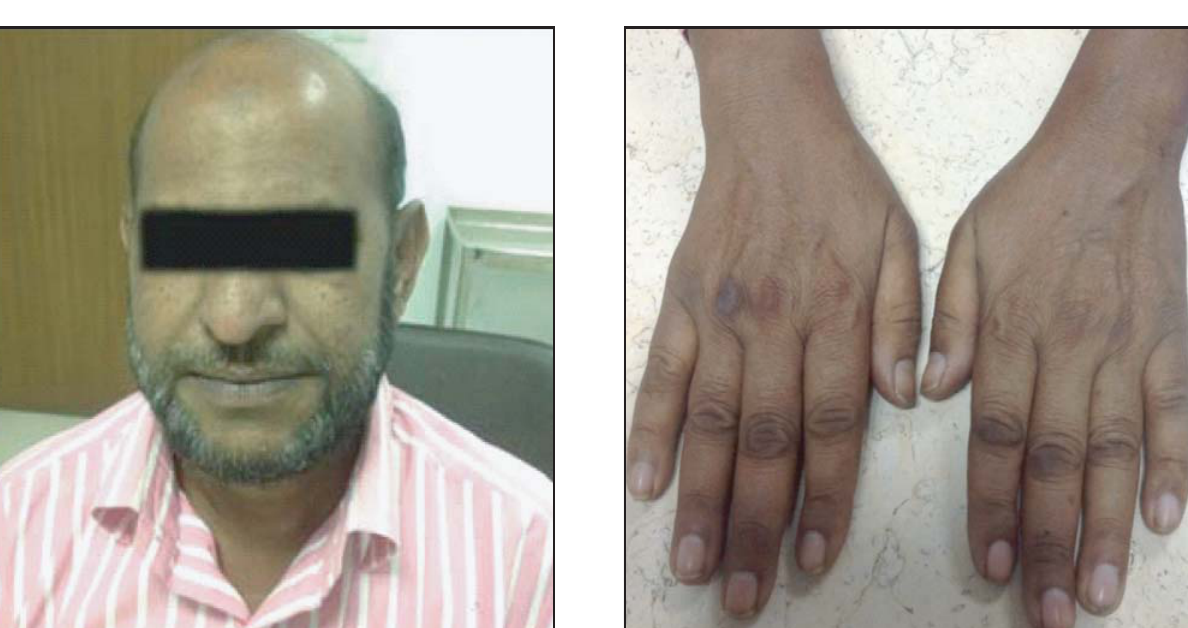
Fig 1. Hyperpigmentation of face Fig 2. Hyperpigmentation of hands